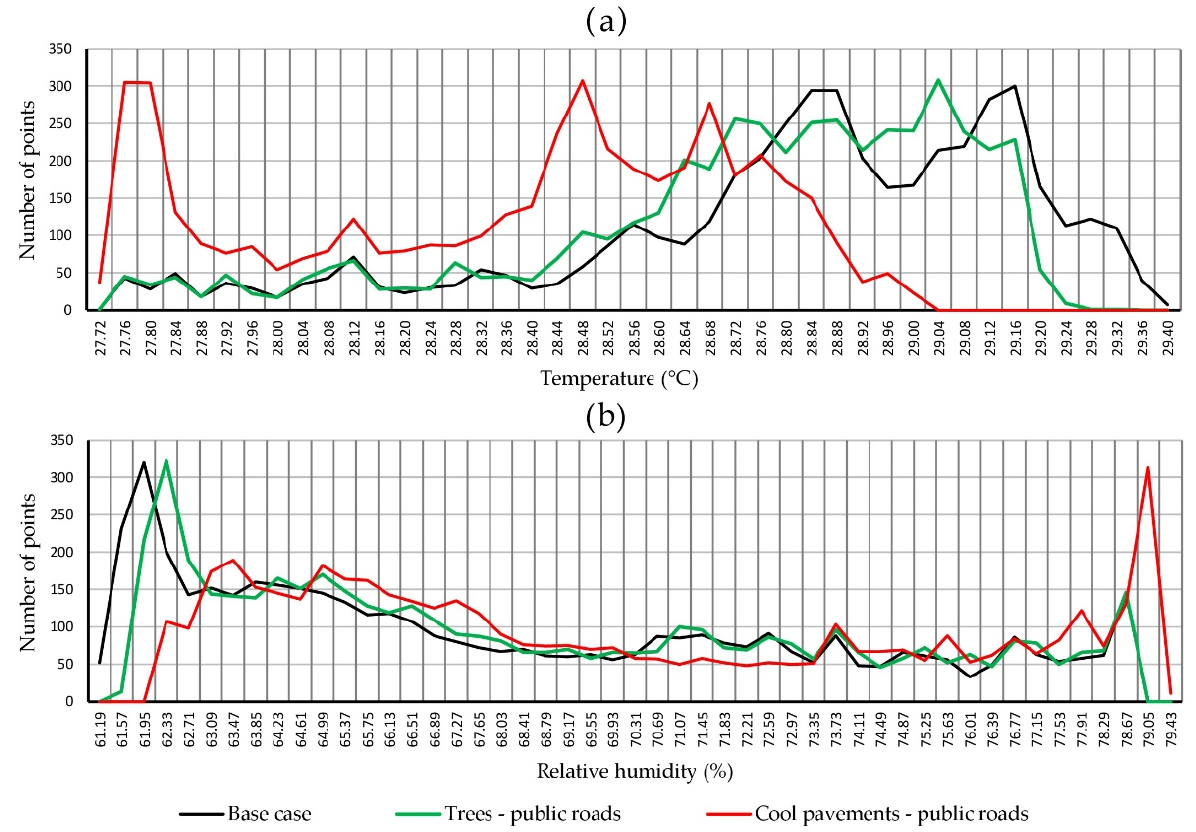
Figure 7. Distribution of the number of points in the modelled grid related to the external air temperature ( a ) ( ◦ C) and the relative humidity ( b ) (%) considering the base case and the two configurations for the urban retrofitting with trees and cool pavements included on the public roads of the industrial district.